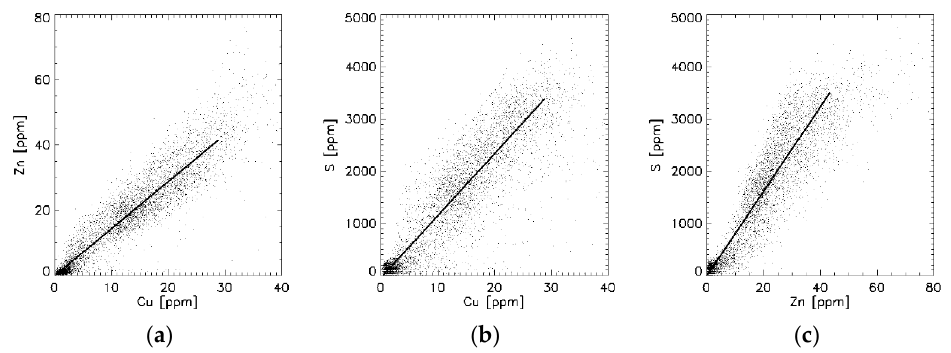
Figure 5. Correlations between elements for a WD-GB. ( a ) Cu/Zn = 1.28; r s = 0.94. ( b ) S/Cu = 119; r s = 0.91. ( c ) Correlations between S/Zn = 81, r s = 0.93. For all p < 0.001.